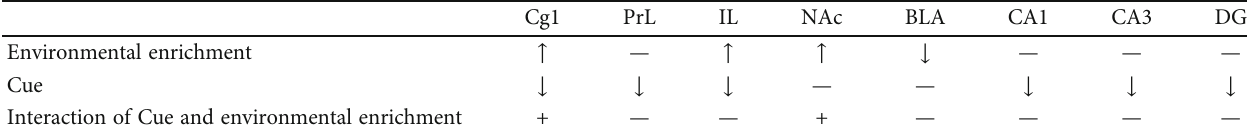
Table 2: E ff ects of environmental enrichment and cue for PTSD in the c-Fos expression for selected brain areas in the situational reminder phase.